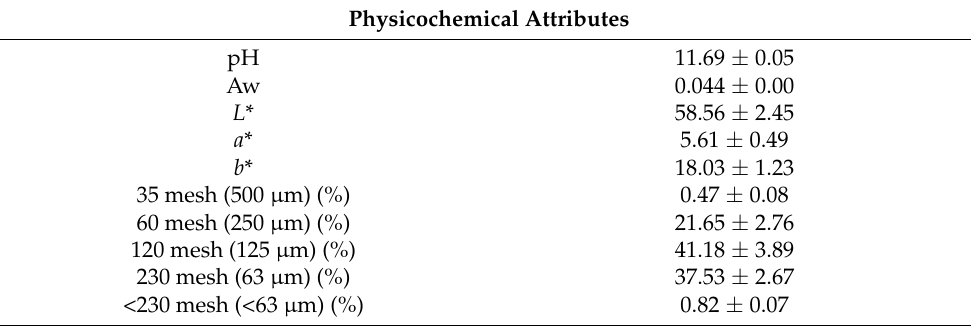
Table 3. Physicochemical properties of the mushroom protein